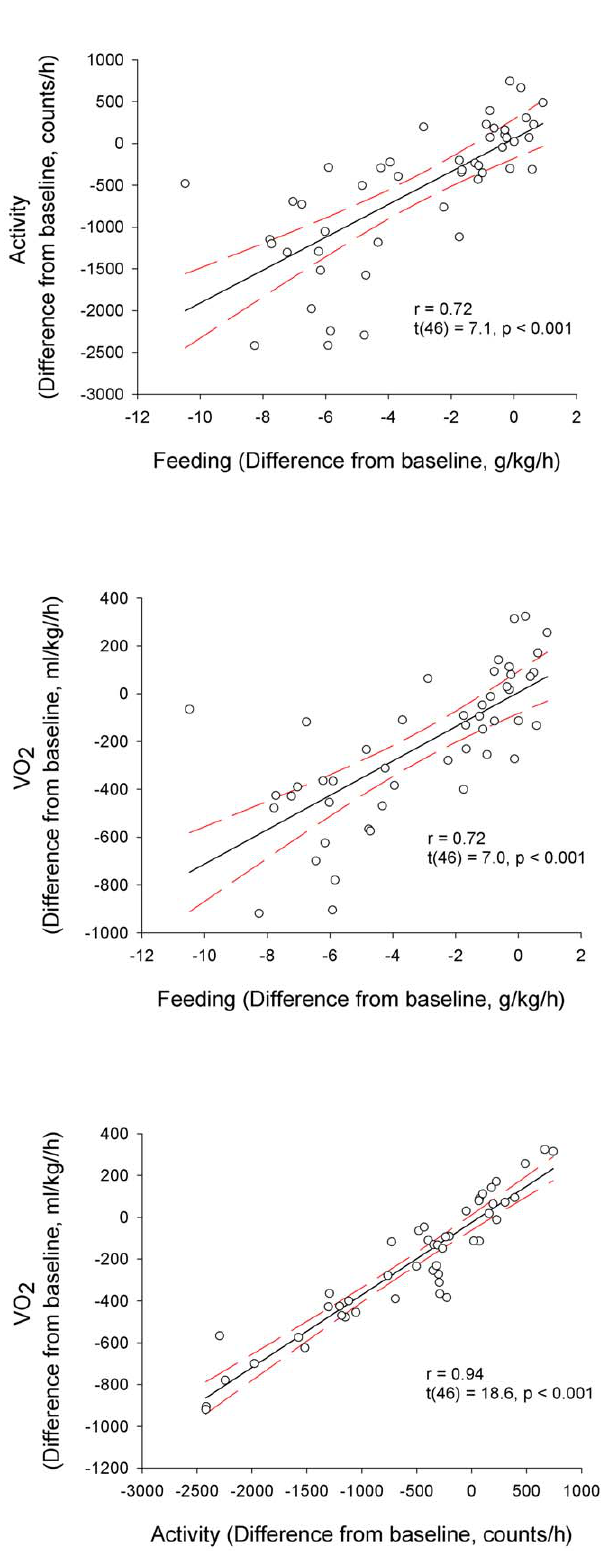
Figure 6. Correlation between the effects of 15 mg/kg C75 on feeding and activity (upper panel), on feeding and VO 2 (middle panel) and on activity and VO 2 (bottom panel). Pearson correlation was calculated from the 1-h differences between C75 and vehicle day. Data from both genotypes are pooled. Dashed lines: 95% confidence intervals.